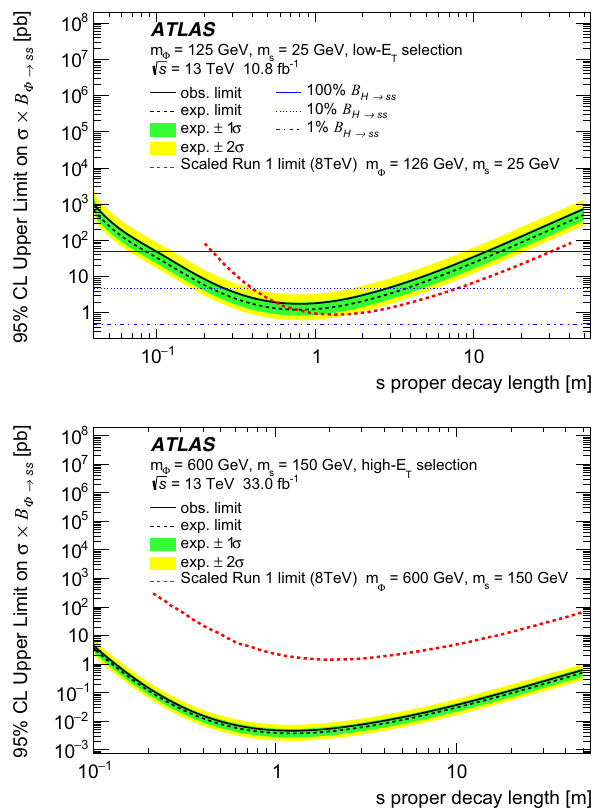
Fig. 8 The observed limits, expected limits and ± 1 σ and ± 2 σ bands for two models with m (cid:4) = 125 GeV , m s = 25 GeV and m (cid:4) = 600 GeV , m s = 150 GeV. The top plot also shows the SM Higgs bosongluon–gluonfusionproductioncrosssectionfor m H = 125 GeV, assumed to be 48.58 pb at 13 TeV [71]. Both plots show a comparison with the limits obtained for a comparable model in the Run 1 analysis [37] scaled by the ratio of parton luminosities for gluon–gluon fusion between 13 and 8 TeV for a particle of appropriate mass